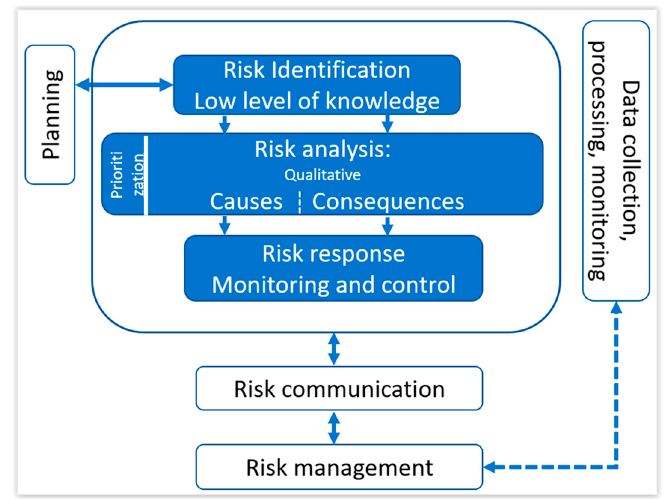
Figure 1. Risk management for low-level of